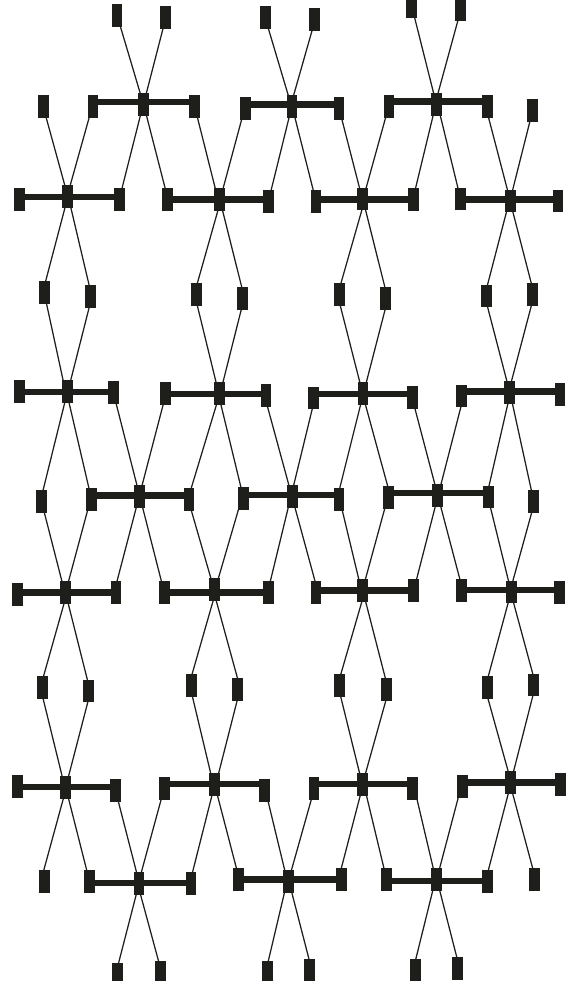
Figure 4: Sheet for m � 2 and n � 3 (bismuth tri-iodide). ( m × n )) 3